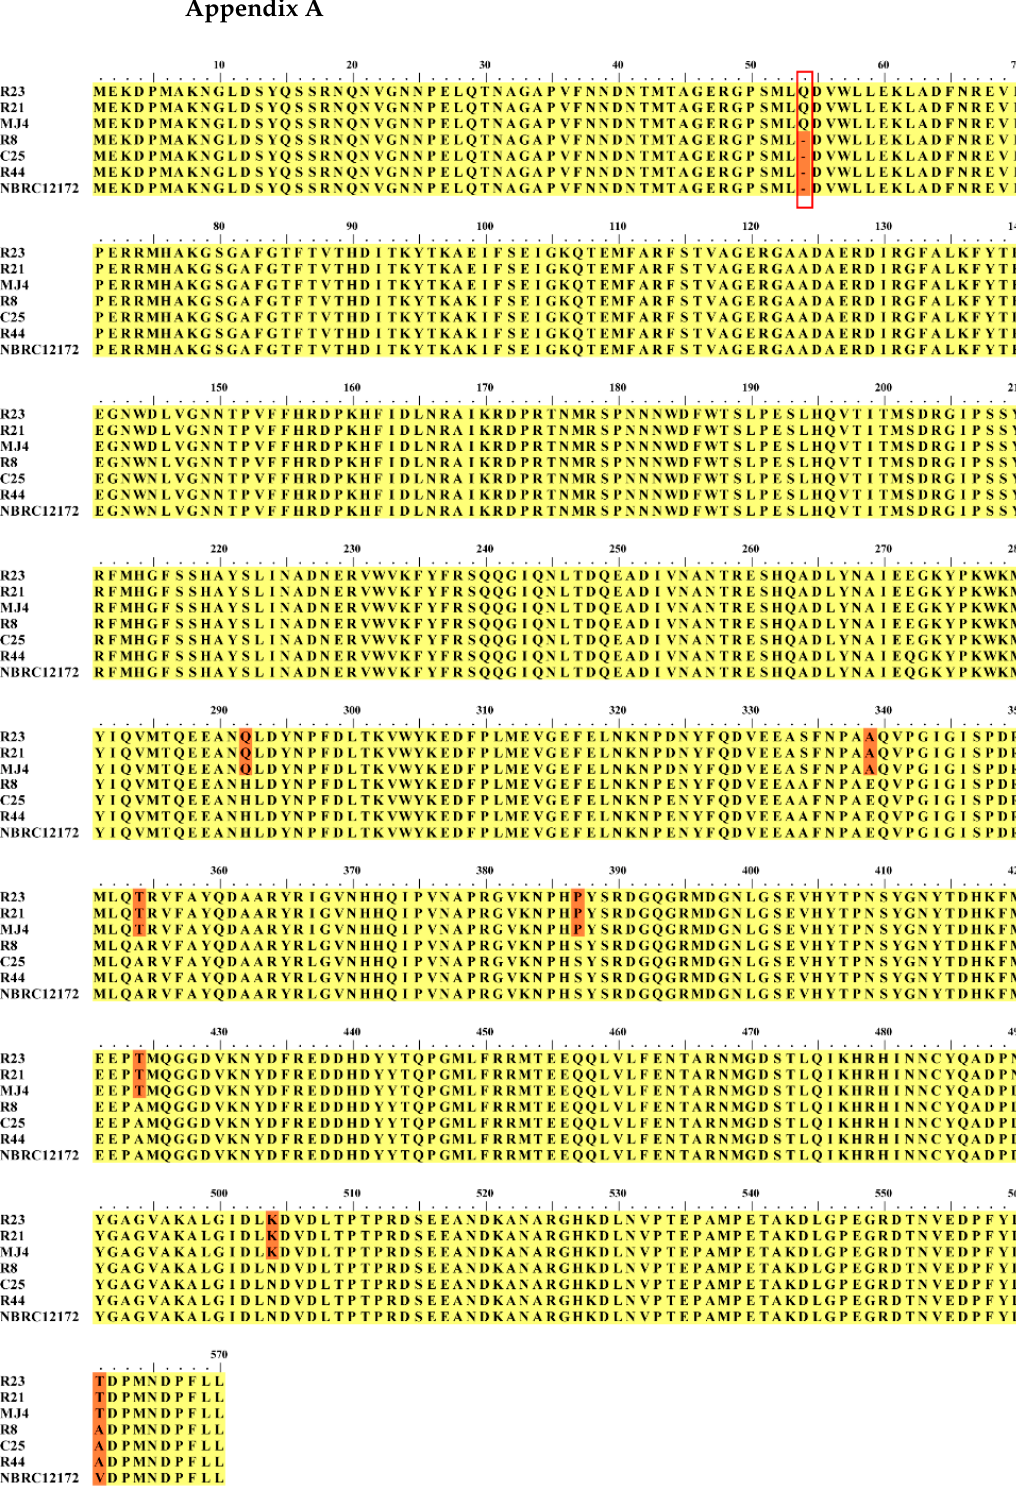
Figure A1. Alignment of catalase amino acid sequence. Sequence alignment of the catalase was done with BioEdit 7.0 using the ClustalW method. Residues highlighted in orange indicate differences in the amino acid sequence of the catalase from T . halophilus . The presence of internal stop codon was shown in